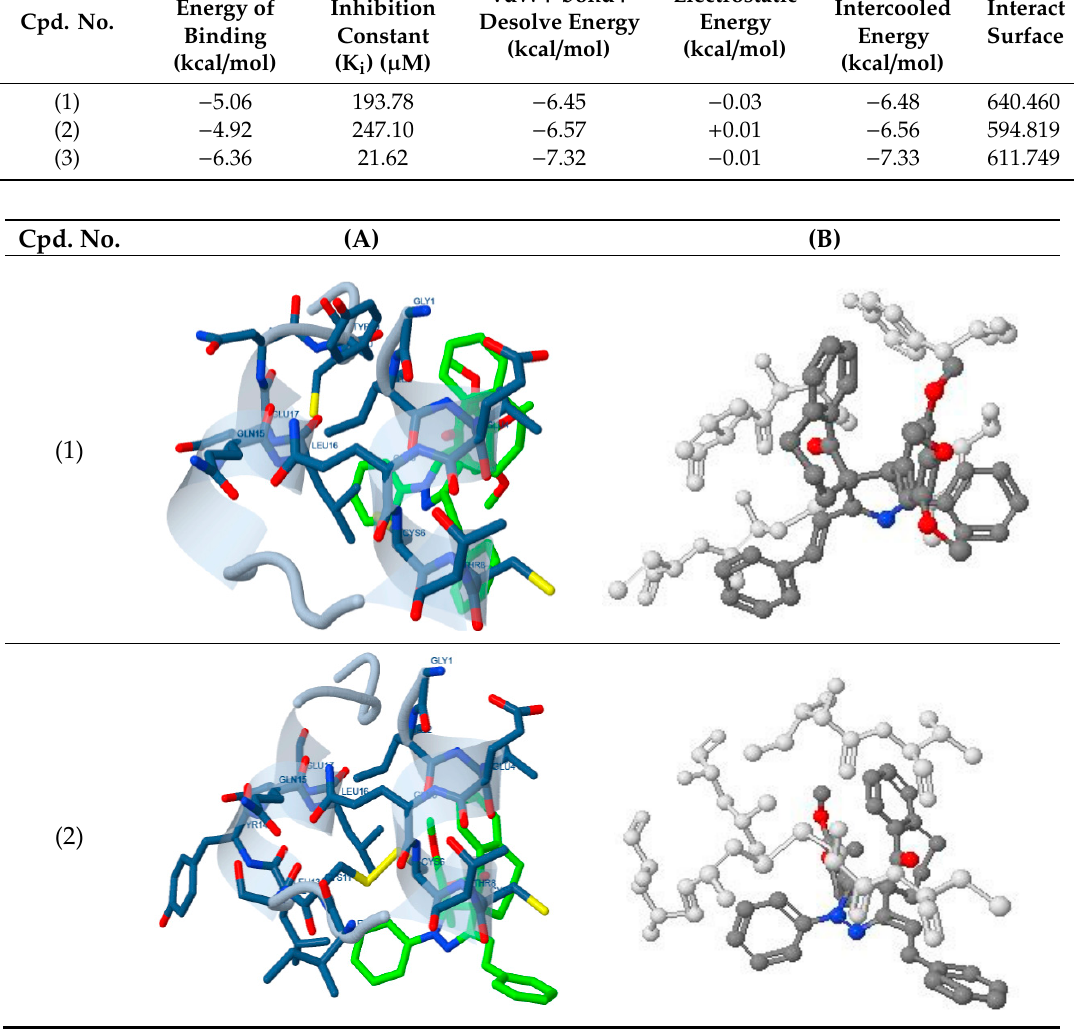
Table 5. Energy data gotten in docking measurements of spiropyrazoles derivatives with 3tt8 receptor. Cpd. No.